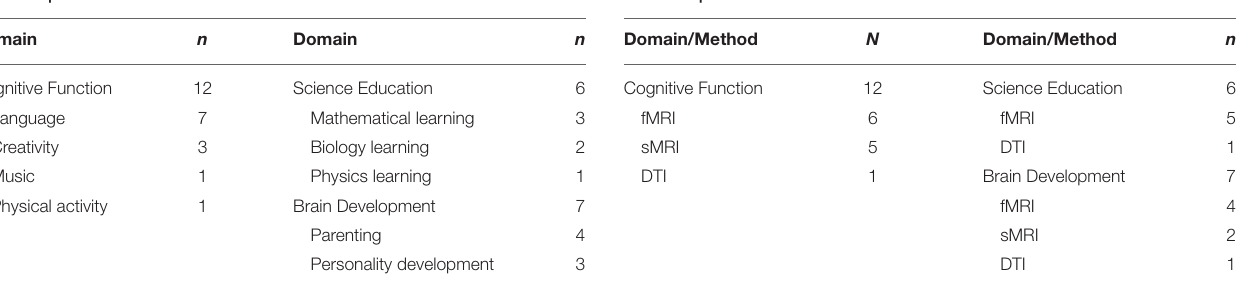
TABLE 2 | Number of reviewed studies in terms of domain and sub-domain. TABLE 3 | Number of reviewed studies in terms of domain and